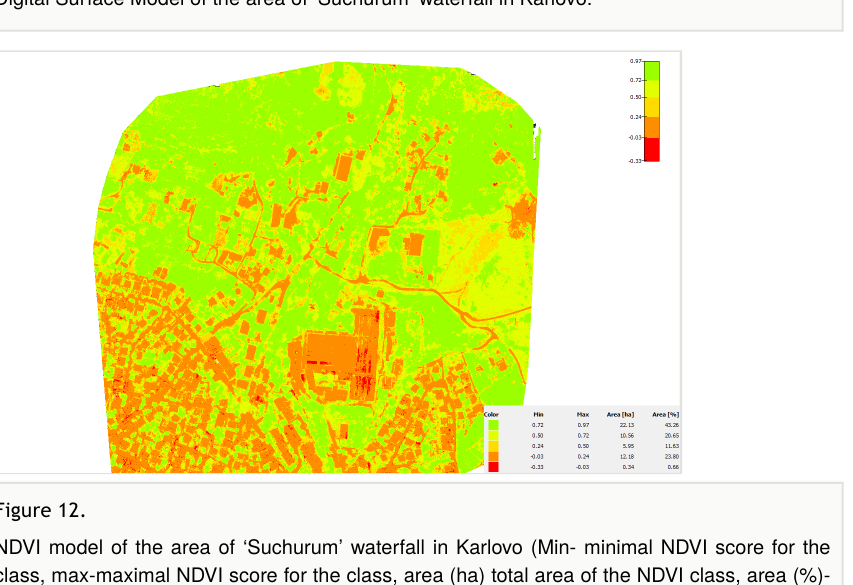
For more than 40% of the whole territory, the index values above 0.7 were calculated. These values show a high level of plant vitality and relatively good spatial coverage.